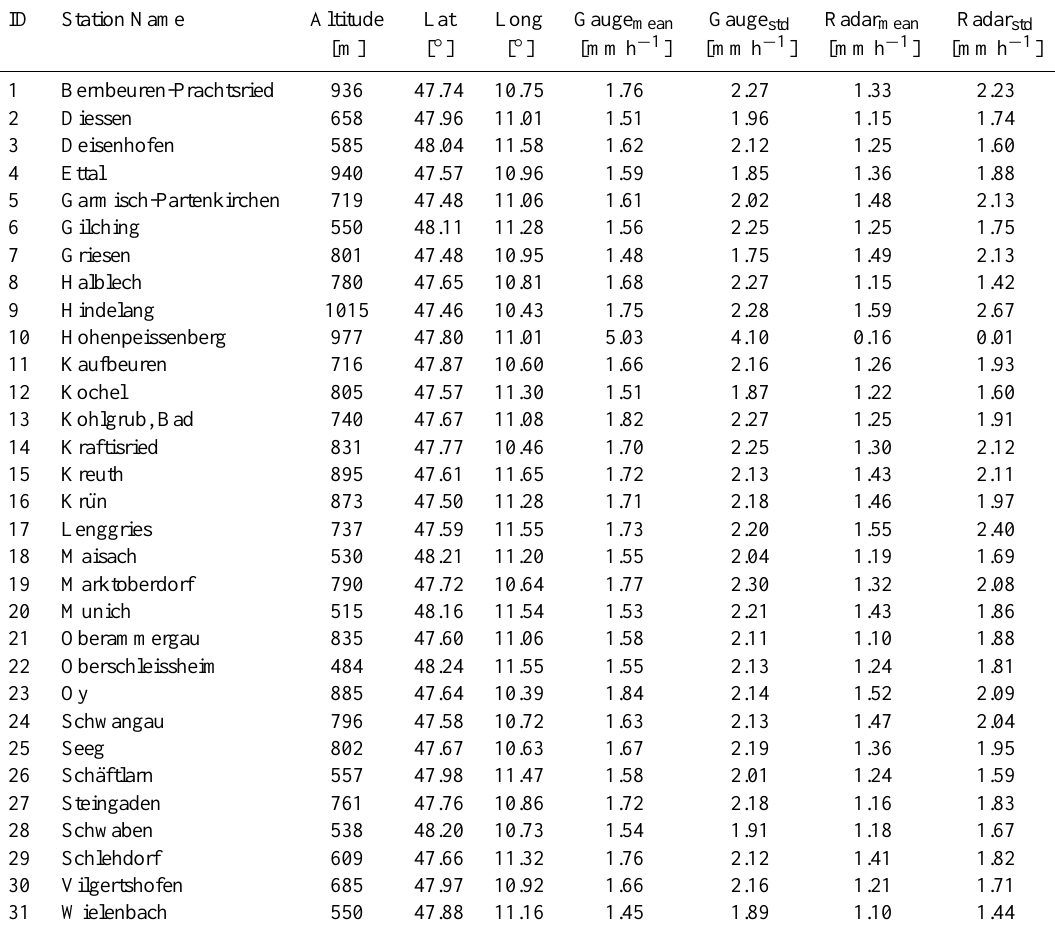
Table 1. Geographical location of gauges and the weather radar as well as statistical measures for gauge & radar (positive pairs only) for period June, July, and August of 2006 and